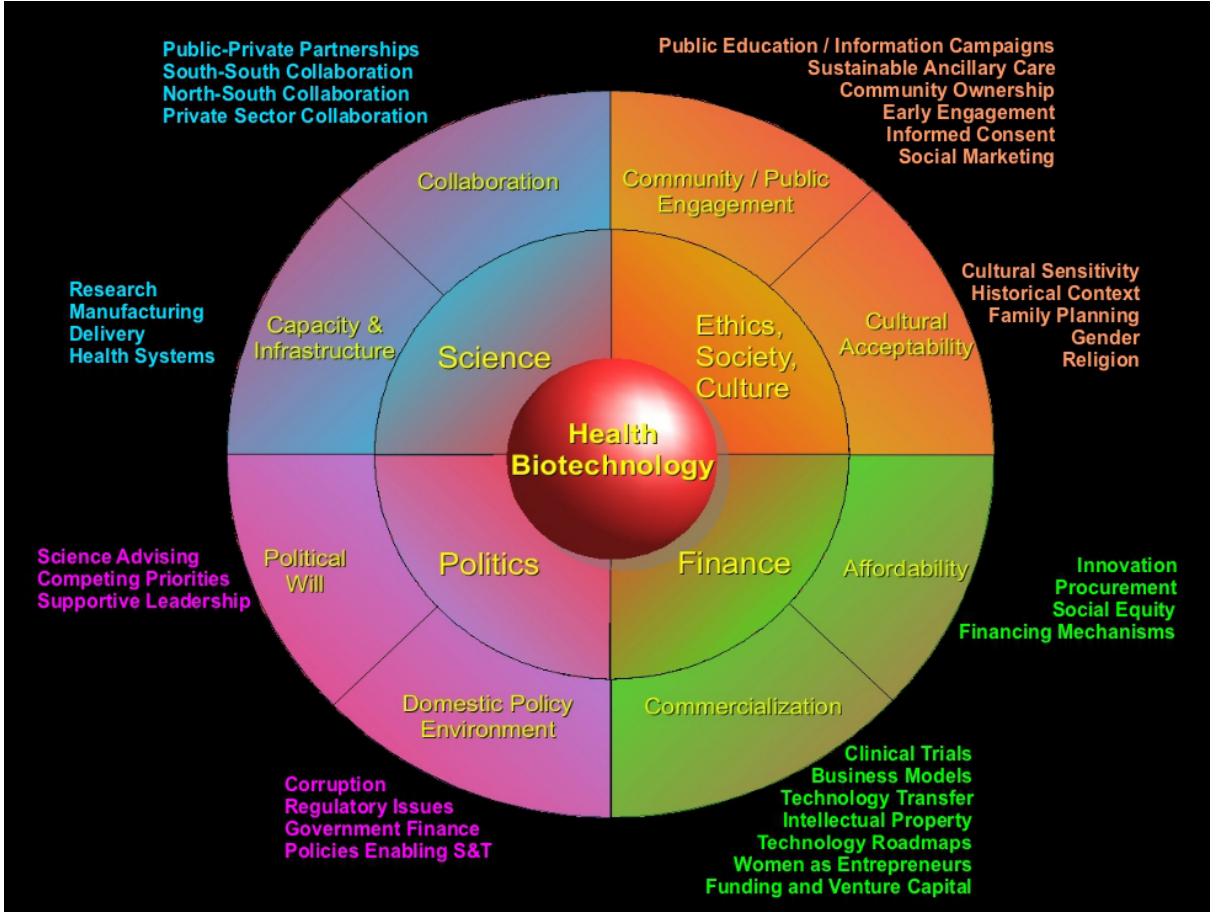
Figure 1. Forces affecting the development and adoption of health biotechnology in developing